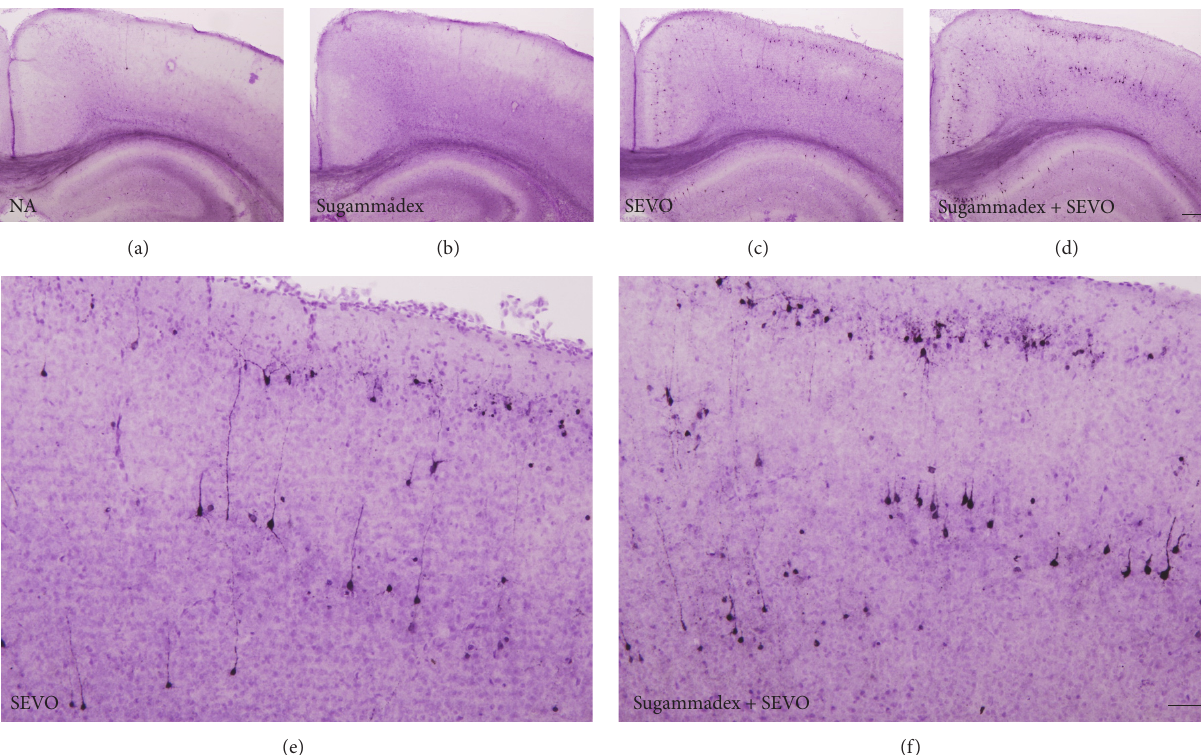
Figure 3: Cleaved caspase-3 activation in the retrosplenial cortex of the brain. Black dots indicate cleaved caspase-3-positive cells in the (a) nonanesthesia (NA), (b) sugammadex, (c, e) sevoflurane (SEVO), and (d, f) sugammadex + SEVO groups. Scale bars: 200 𝜇 m (a–d); 50 𝜇 m (e, f). Six hours of neonatal sevoflurane exposure increased the number of cleaved caspase-3-positive cells, indicating apoptosis. The intraperitoneal administration of sugammadex significantly enhanced neuronal apoptosis associated with neonatal 2% sevoflurane